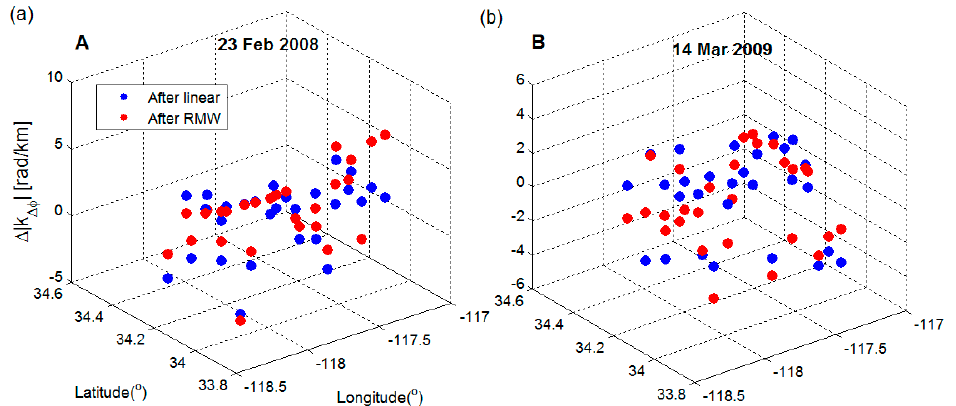
ˇ k ∆ ˇ after correction using φ